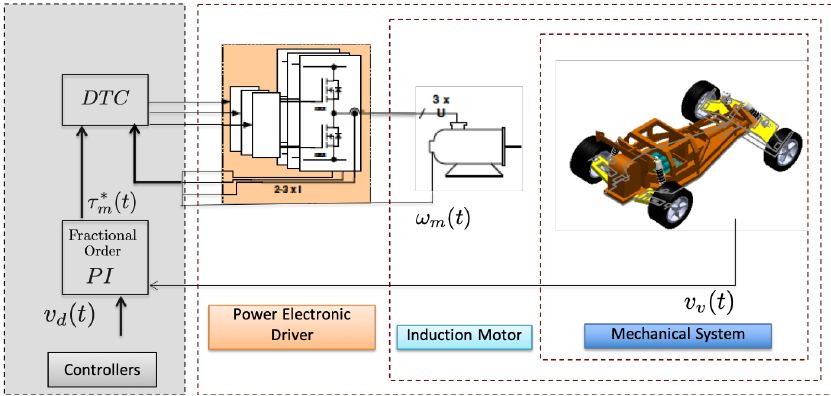
Figure 7. Block diagram of the control